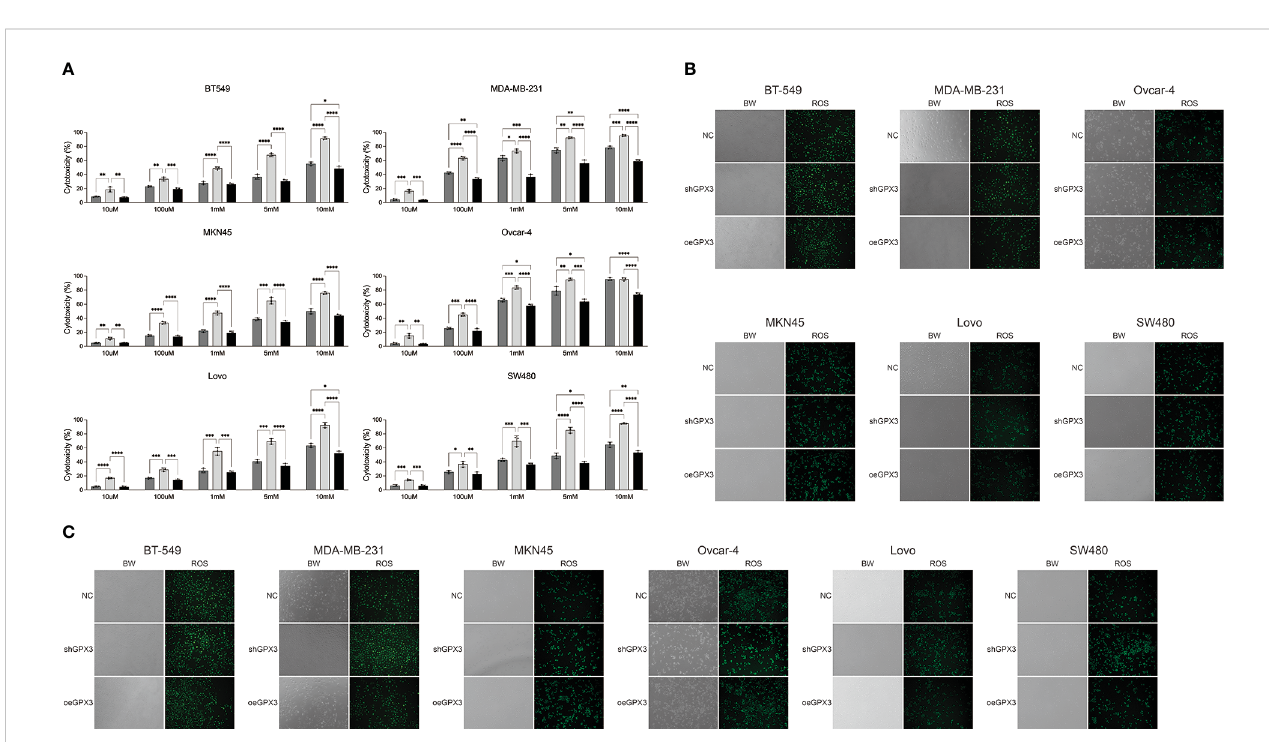
FIGURE 8 Knockdown GPX3 increased oxidative stress damage in human cancer. (A) Cell viability was assessed 24h following treatment with H 2 O 2 by using cck-8 assay. (B) ROS in shGPX3, oeGPX3 and corresponding control cells was assessed by using DCFH-DA probe. (C) ROS in cells was assessed 4h following treatment with H 2 O 2 by using DCFH-DA probe. *(p<0.05), **(p<0.01), ***(p<0.001),